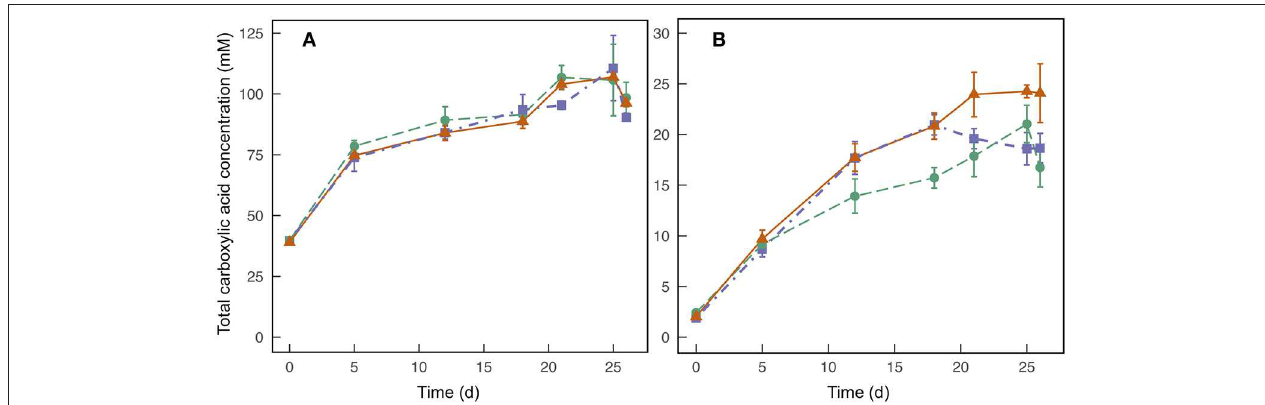
FIGURE 1 | Average total concentrations of n -butyric acid (A) and n -caproic acid (B) found in triplicate batch-fermentation media bottles for Experiment 1, which were started with inoculum from a semi-continuous chain-elongation bioreactor ( • ); inoculum from rumen contents of a cow ( (cid:4) ); and no inoculum ( N ). Error bars indicate standard deviations of the measured